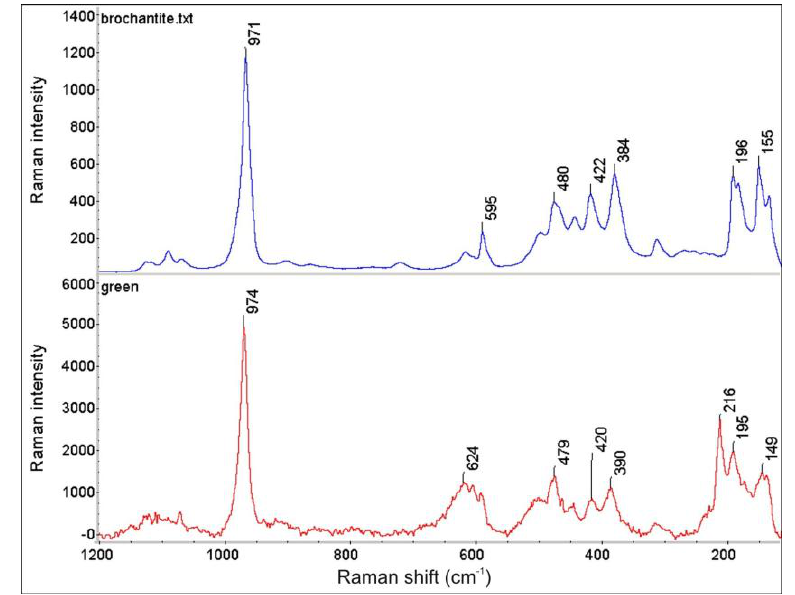
Figure 10. Comparison of the Raman spectrum of brochantite Cu with the Raman spectrum from the green corrosion layer shown in Figure 5 (lower plot).